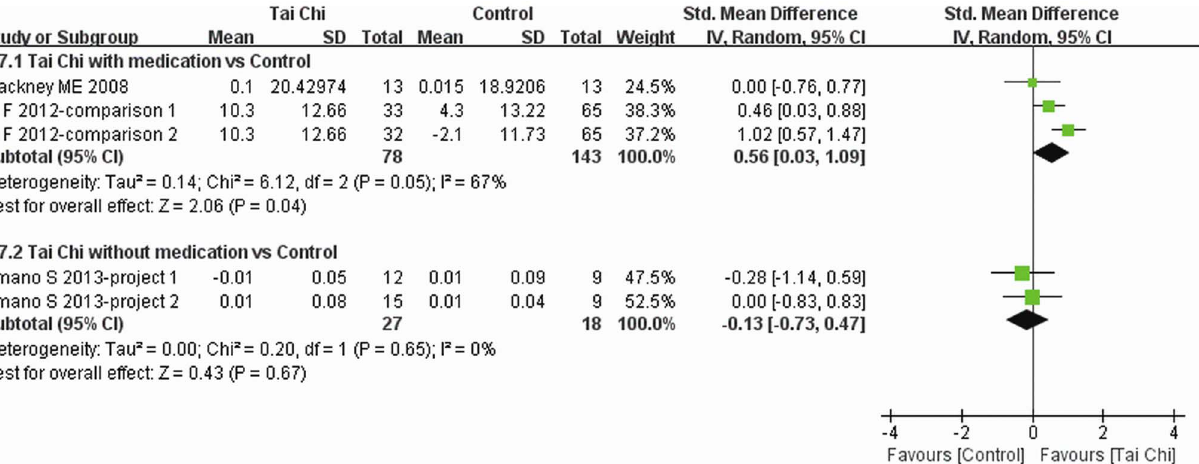
Figure 9. The effect of Tai Chi on stride length. Subgroup analysis was performed according to whether or not medications were included in the intervention. Standardized mean difference was used for different units of stride